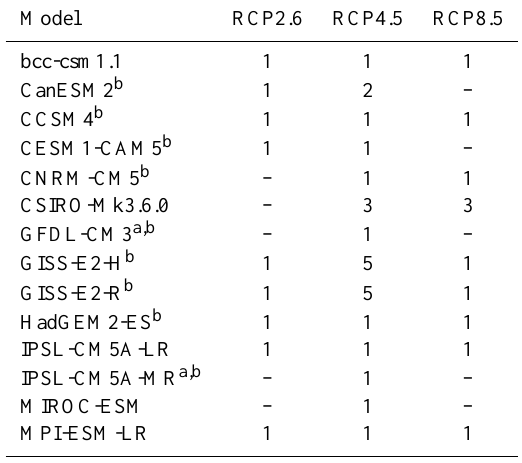
Table 1. Models and number of available ensemble members for each of the extended RCPs. Only one ensemble member (r1i1p1) was used from each of the models in the analysis here. RCP2.6